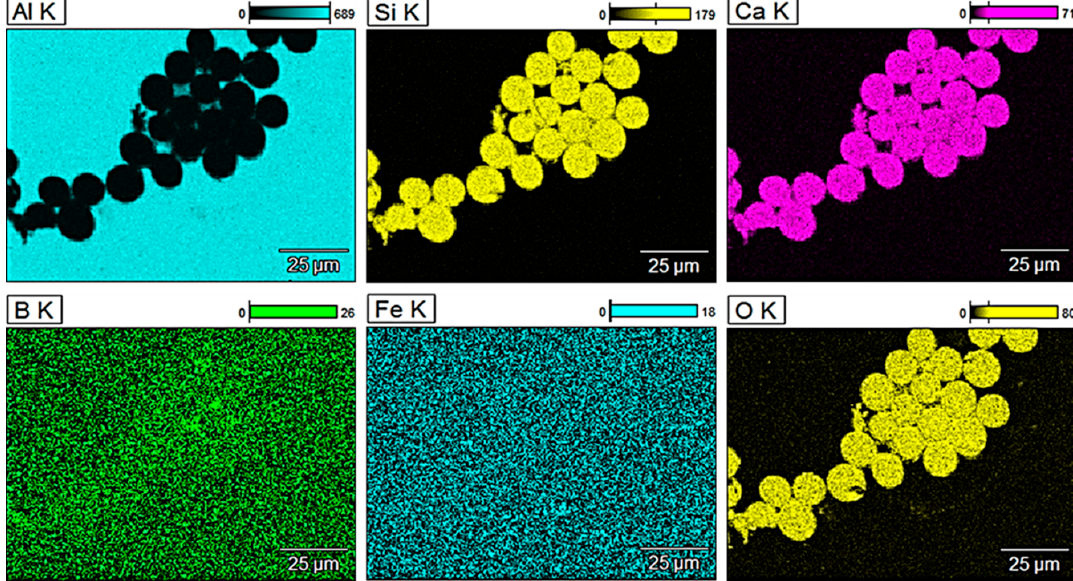
Figure 7. EDX mapping of EN AW 1370 with 5 wt.% of GF reinforcement (extrusion process).